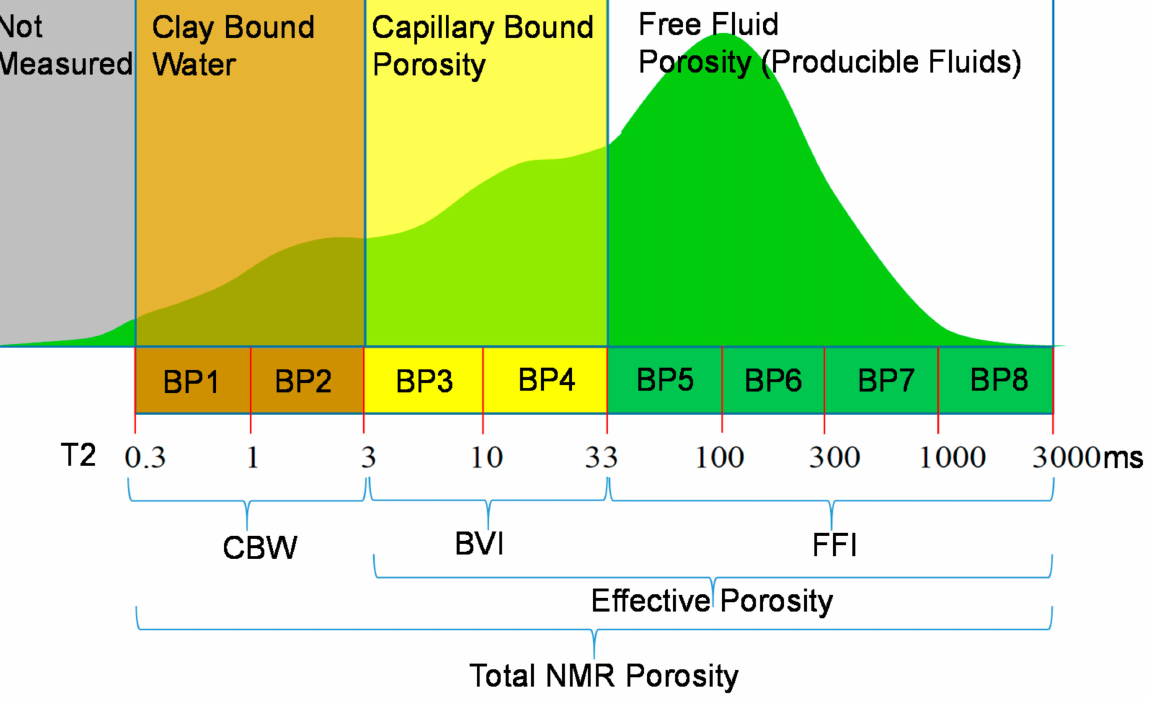
Figure 1. The T 2 distribution shows clay-bound water (CBW), capillary bound fluid (BVI), and free fluid (FFI). These properties are shown in relation to the T 2 signal. From